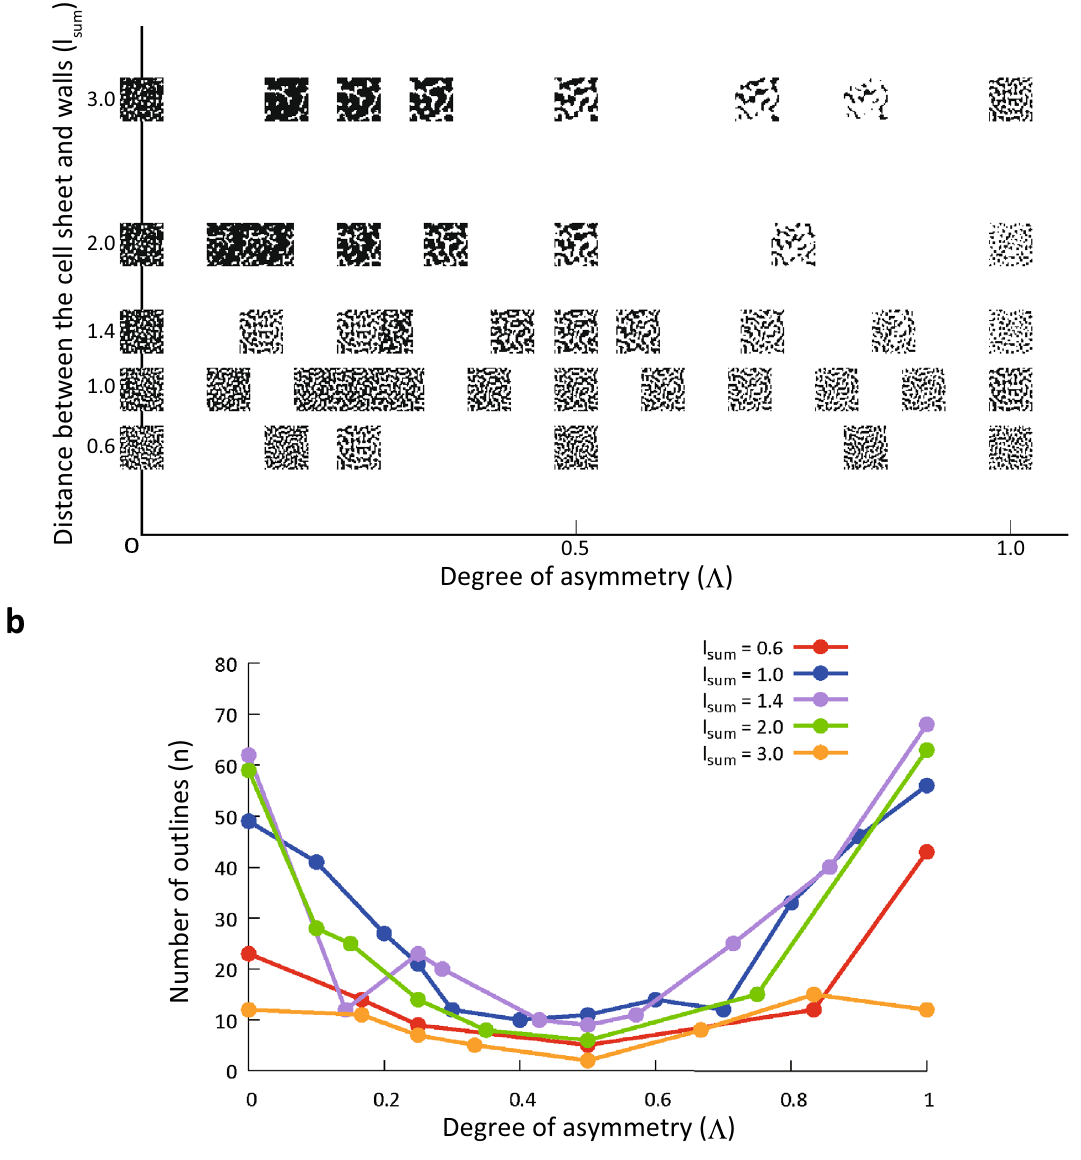
Figure 5. Binarized black-and-white images of the epithelial folding simulation results and the number of folds. ( a ) Relation between environment and folding pattern. The horizontal axis is the degree of asymmetry (cid:31) . The vertical axis is the sum of distances between the cell sheet surfaces and walls l sum . ( b ) Relation between degree of asymmetry (cid:31) and number of outlines. The upper right legends show the sum of the distances between the cell sheet surfaces and walls l sum . The number of outlines n was smallest when (cid:31) was 0.5, and n increased as (cid:31) deviated from